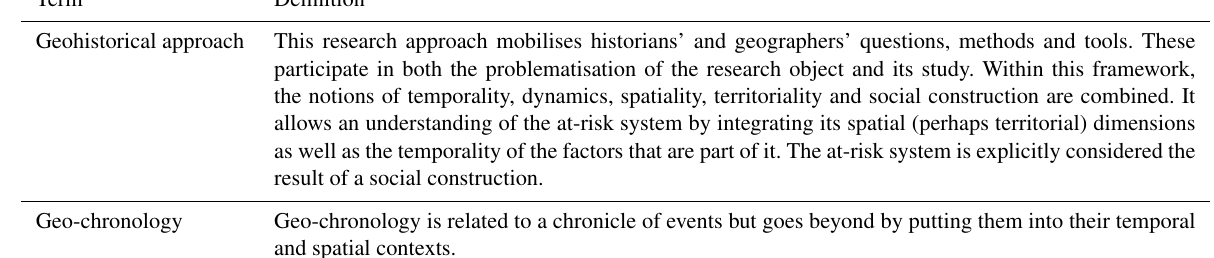
Table 1. Definition of few specific terms arising from the fields of history and social science and used in the present study. Term Definition Geohistorical